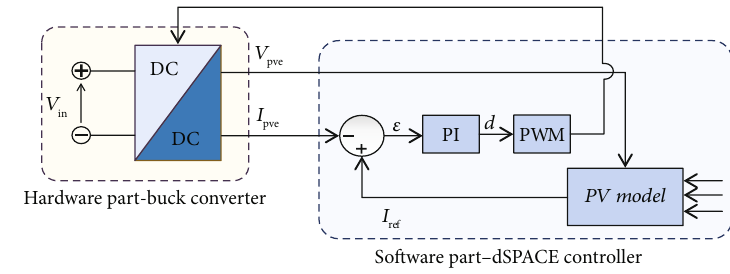
Figure 8: Power stage closed-loop control.